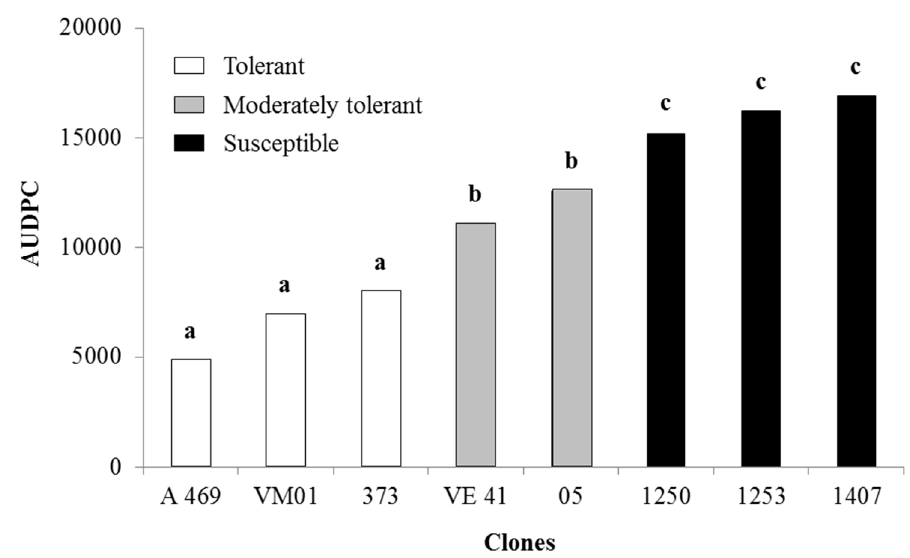
Figure 3. Area under the bacterial-blight-progress curves in different eucalyptus clones. Bars with the same letters indicate grouping of clones ( p ≤ 0.05) by the Scott–Knott test.